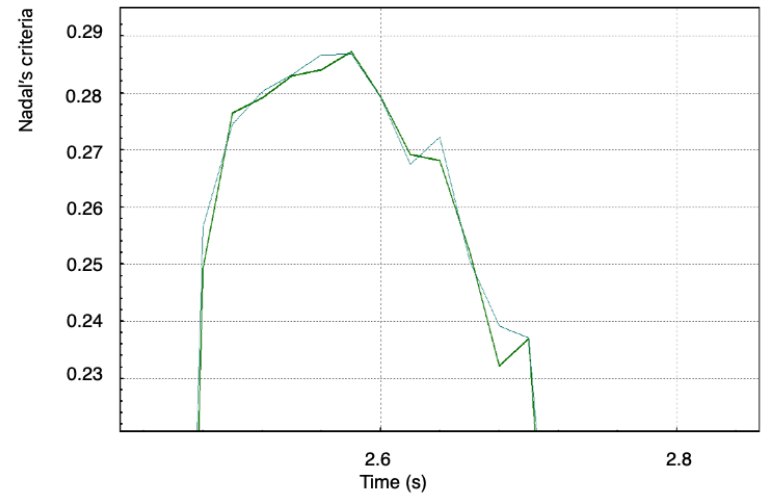
Figure 21. Comparison of the maximum value of Nadal’s criterion for the left front wheel for conventional deflection (L = 3500 mm), in blue, and the proposed deflection (L = 4000 mm), in green.